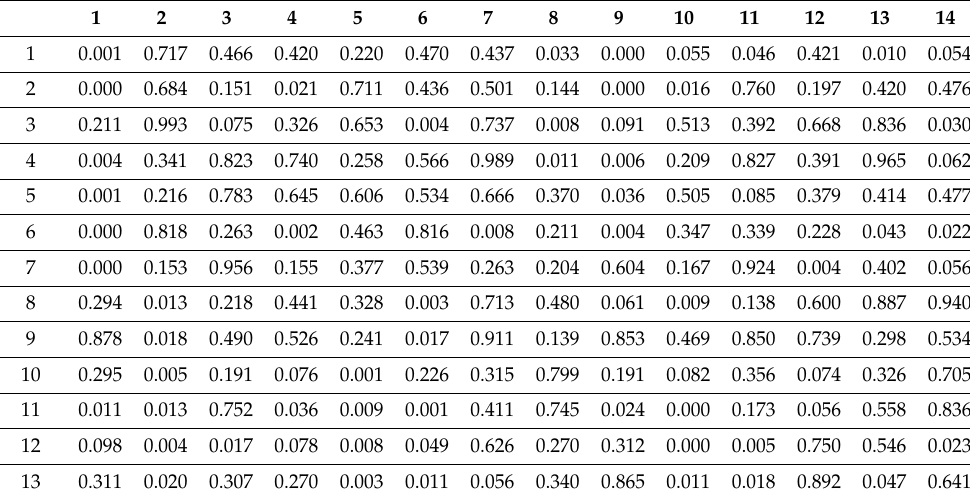
Table 3. Correlation between the tested